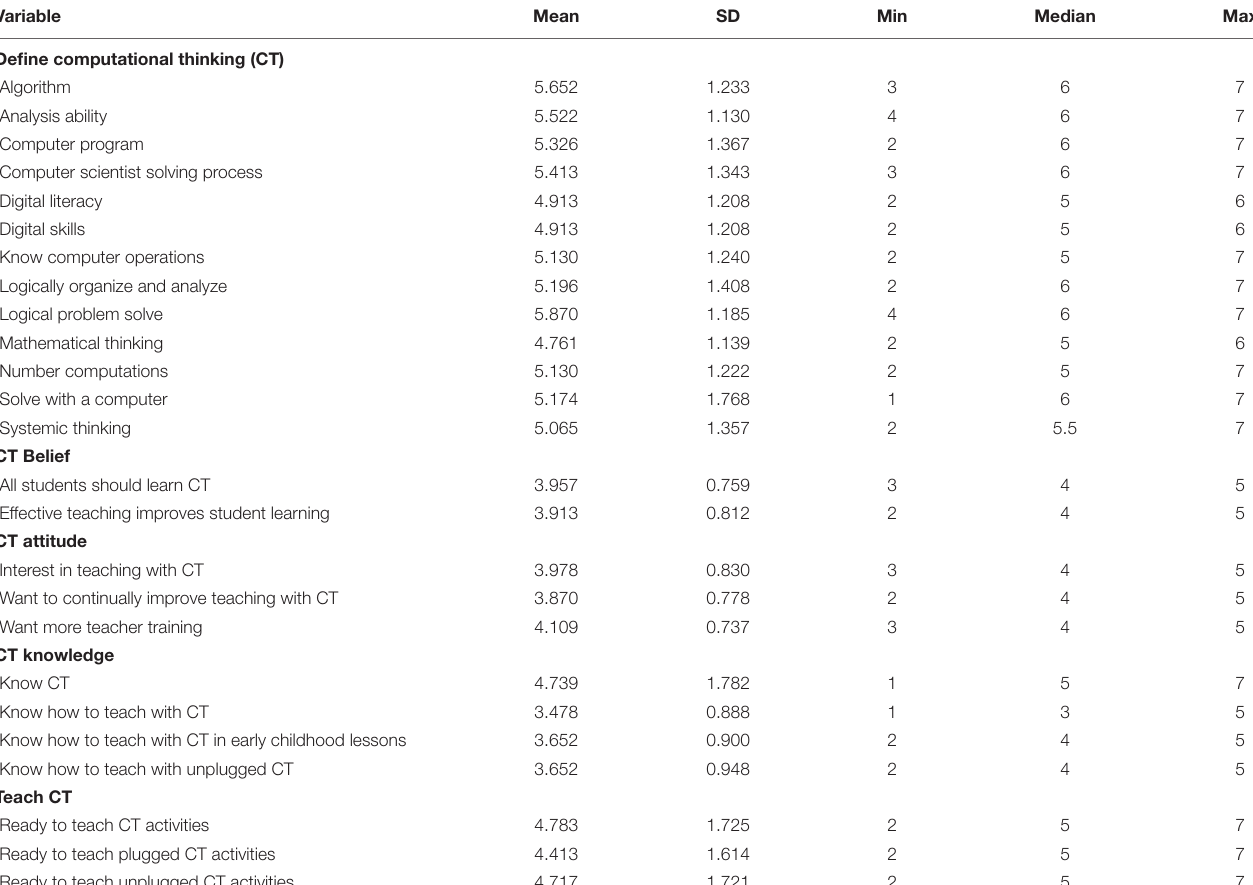
TABLE 3 | Summary statistics ( N =